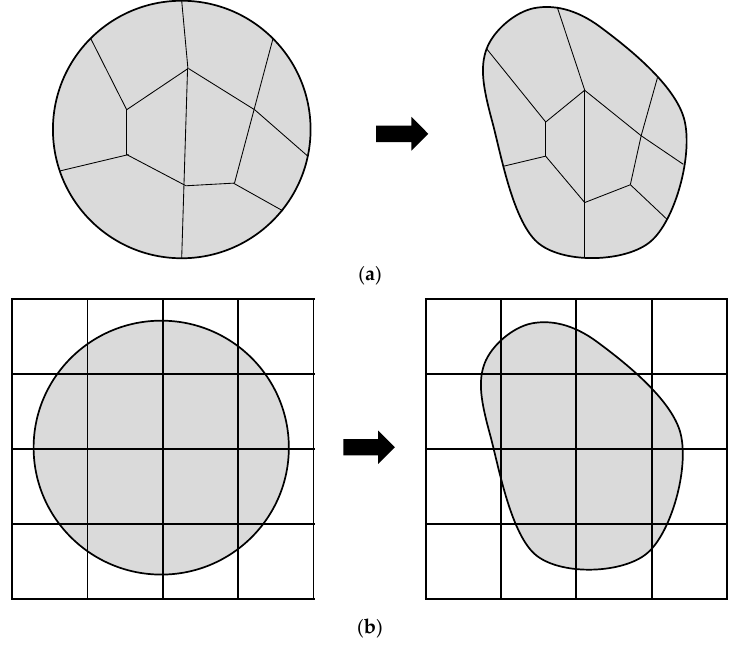
Figure 6. Deformation of a continuum in analysis: ( a ) Lagrangian analysis; ( b ) Eulerian analysis.